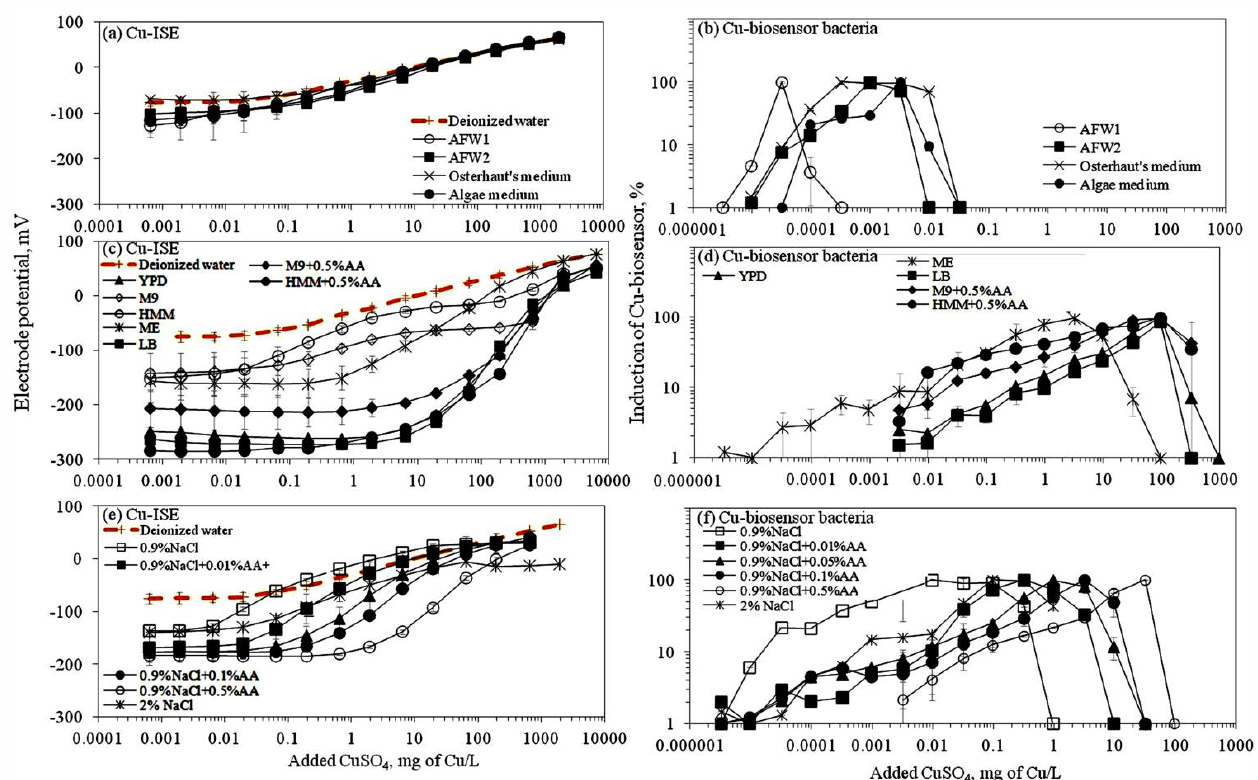
Figure 1. Response of Cu-ISE (left panels) and Cu-biosensor Pseudomonas fluorescens OS8::KnCueRPcopAlux (right panels) to CuSO in different ecotoxicological and 4 microbiological media. ( a , b ) ‘poor’ mineral media; ( c , d ) organics-containing media (LB, ME, YPD) and mineral media (M9, HMM) supplemented with 0.5% of Cas-amino acids; ( e , f ) 0.9% NaCl with various concentrations of Cas-amino acids (AA). Numeric values of respective LODs are presented in Table